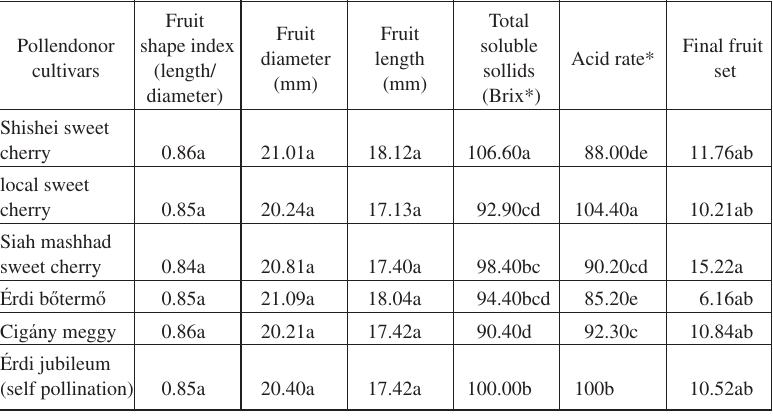
Table 7. Qualitative and quantitative traits of Érdi jubileum cultivars obtained from cross pollination with pollinizers Fruit Total Pollendonor shape